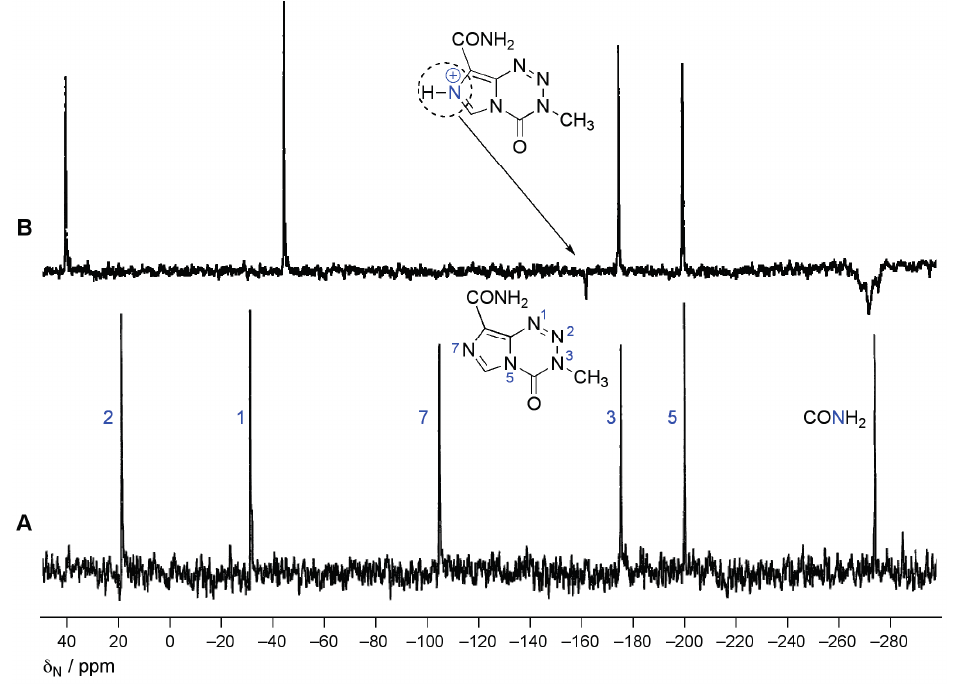
Figure 6. 15 N-NMR spectra of TMZ. ( A ) 15 N{ 1 H} in DMSO- d TFA. Both experiments were acquired in the presence of Cr(acac) external CH NO 3 2